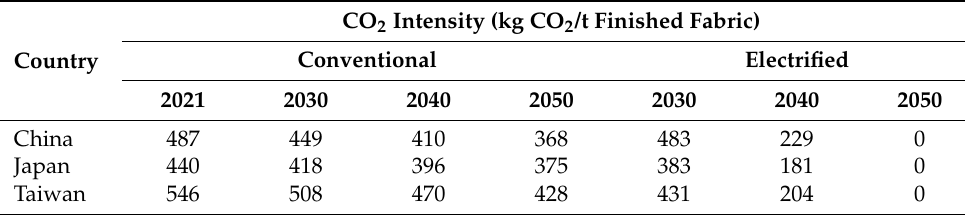
Table 6. The CO 2 intensity of the conventional and electrified dyeing process.